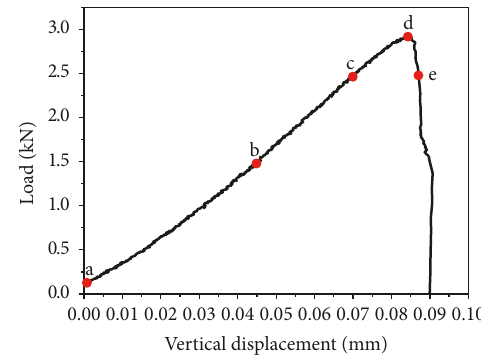
Figure 13: Relationship between load and vertical displacement for 𝛽 = 54 ∘ and 2𝑎 = 15